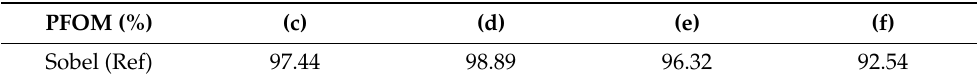
Figure 6. ( a ) Original image and images obtained using the existing mask algorithms: ( b ) Sobel, ( c ) 2 × 2 (Roberts, Proposed), ( d ) 3 × 3 (Proposed), ( e ) 4 × 4, and ( f ) 5 × 5. Table 2. Pratt’s figure of merit (PFOM) at the global threshold value.